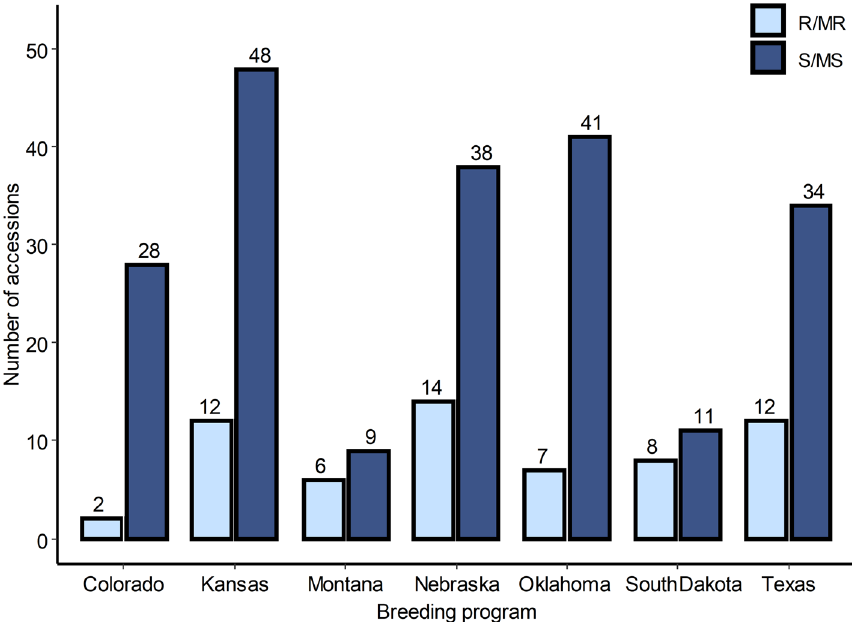
Figure 5. Distribution of the SNB resistance among the 274 accessions of hard winter wheat association mapping panel (HWWAMP) originating from different breeding